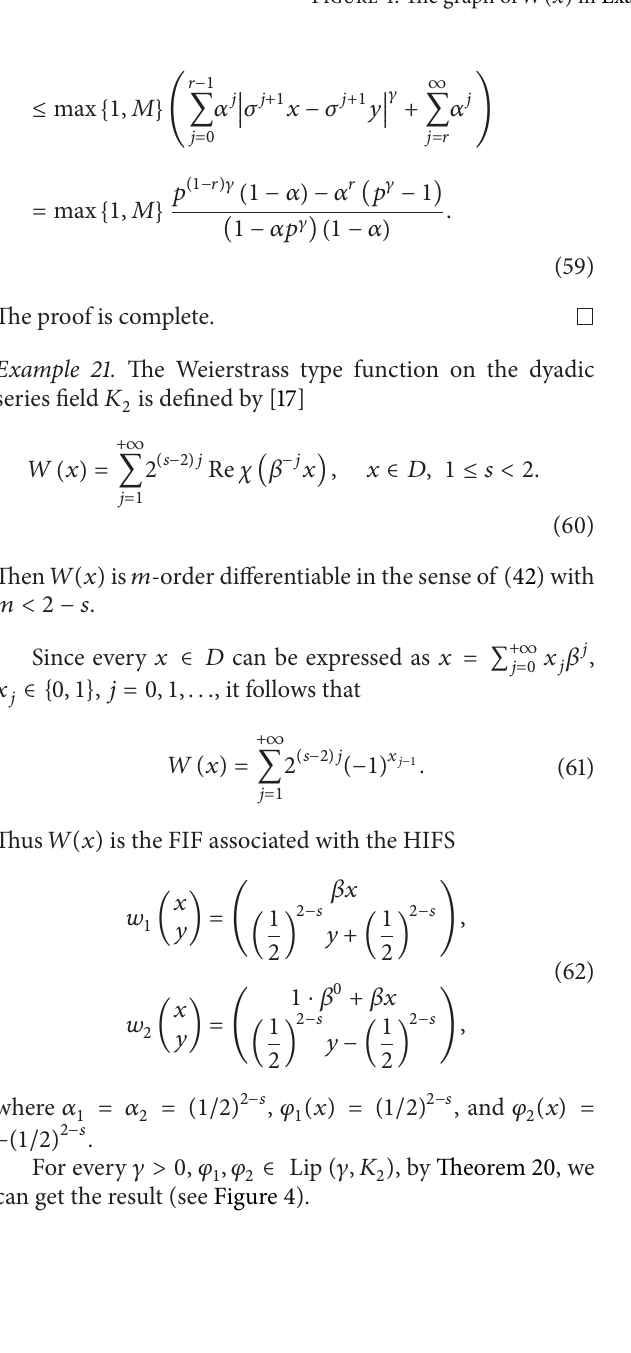
Figure 4: The graph of 𝑊(𝑥) in Example 21 with 𝑠 = 1.7 and 𝑠 = 1.3